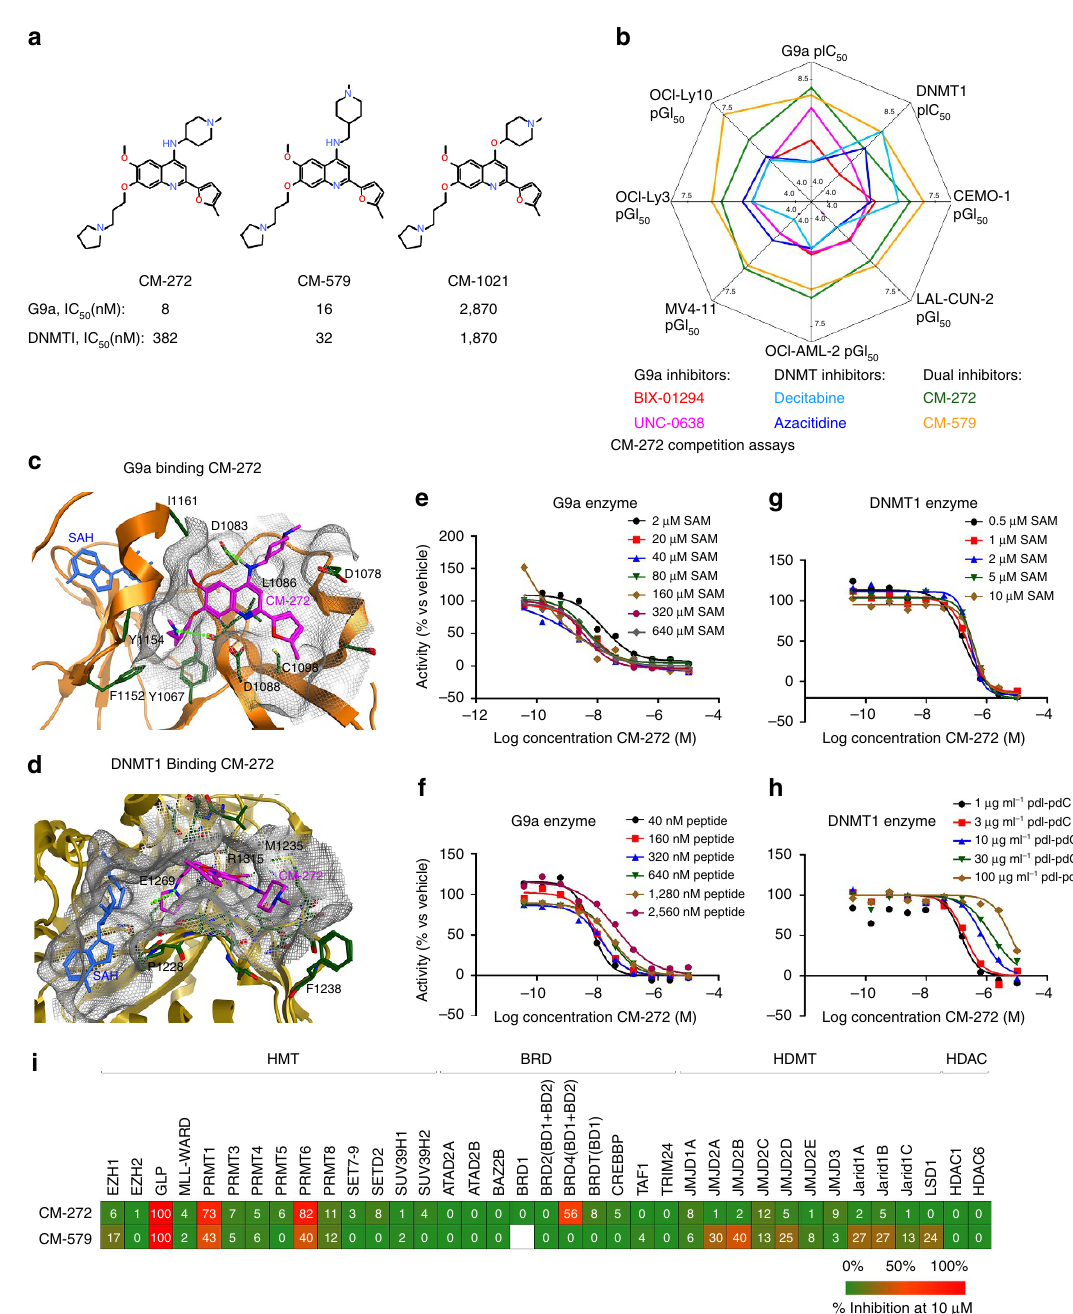
Figure 1 | Small molecules with a dual inhibitory activity against G9a and DNMT. ( a ) Chemical structure of CM-272, CM-579 and CM-1021 together with their IC 50 values against G9a and DNMT1 activity. ( b ) Radar plot showing the in vitro G9a and DNMT1 inhibitory potencies (expressed as pIC 50 ) and the growth inhibitory potencies (expressed as pGI 50 ) against different cell lines (AML: MV4-11 and OCI-AML-2: ALL: CEMO-1 and LAL-CUN-2 and DLBCL: OCI-Ly10 and OCI-Ly3) for compounds CM-272, CM-579, selective G9a inhibitors (BIX-01294 and UNC-0638) and irreversible DNMT inhibitors (azacitidine and decitabine). ( c , d ) Plausible binding mode of CM-272 (in pink, blue and red sticks) into the histone binding groove of G9a ( c ) and the DNA binding groove of DNMT1 ( d ). CM-272 does not interact with the corresponding SAM binding pockets (SAH shown in blue sticks). For G9a, the 7-(3-pyrrolidin-1-yl) propoxy side chain of CM-272 interacts with the lysine binding channel. In the case of DNMT1, this side chain is predicted to overlay with the DNA cytosine, occupying the catalytic pocket and interacting with the catalytic glutamate E1269 (mouse DNMT1). ( e – h ) Enzymatic competition assays of CM-272: G9a competition assay with the SAM cofactor ( e ) and with the histone peptide (PepMe1) ( f ) and DNMT1 competition assay with the SAM cofactor ( g ) and with the DNA substrate ( h ). ( i ) Selectivity profile of CM-272 and CM-579 at 10 m M against 37 epigenetic enzyme targets from different